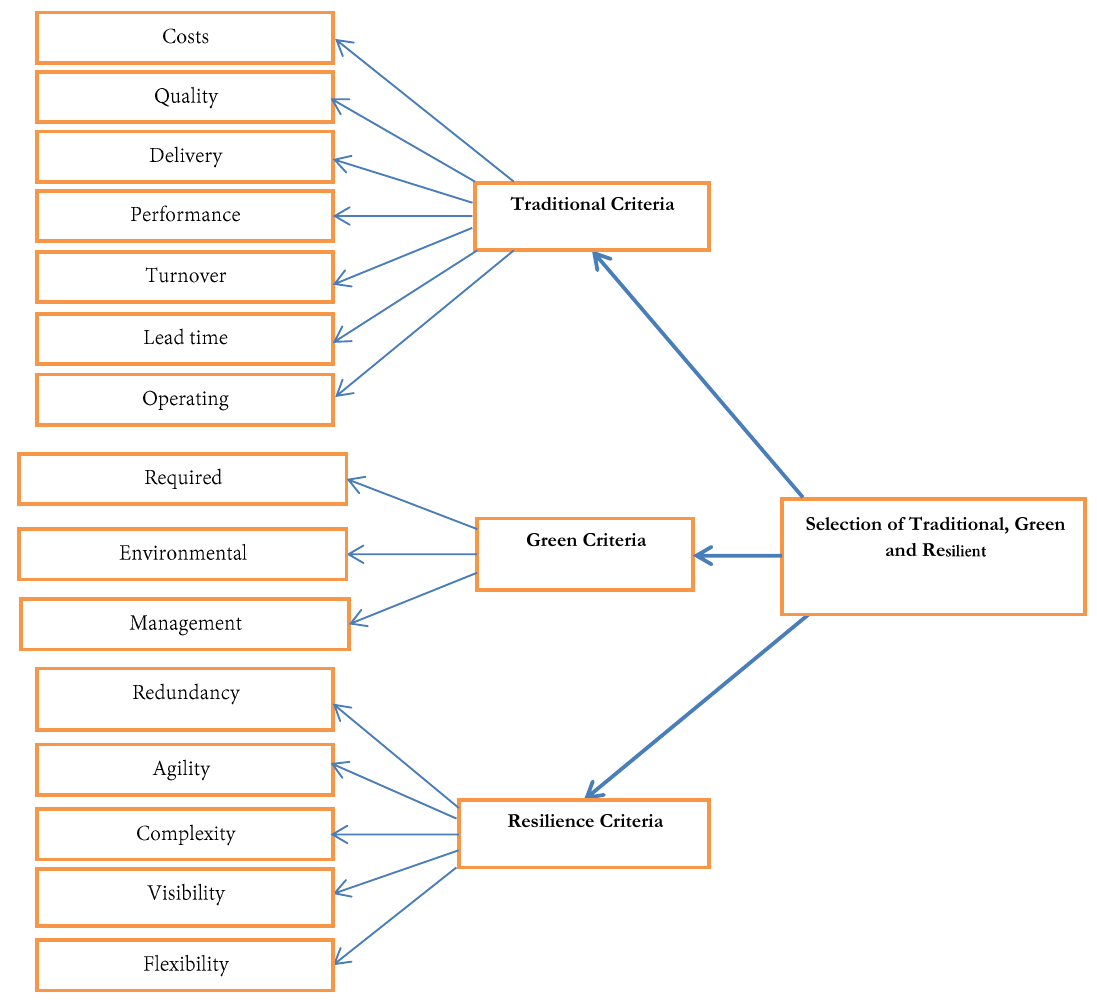
Fig. 1. The conceptual model of the hierarchical series of criteria (traditional, green and resilience) and sub-criteria for selecting